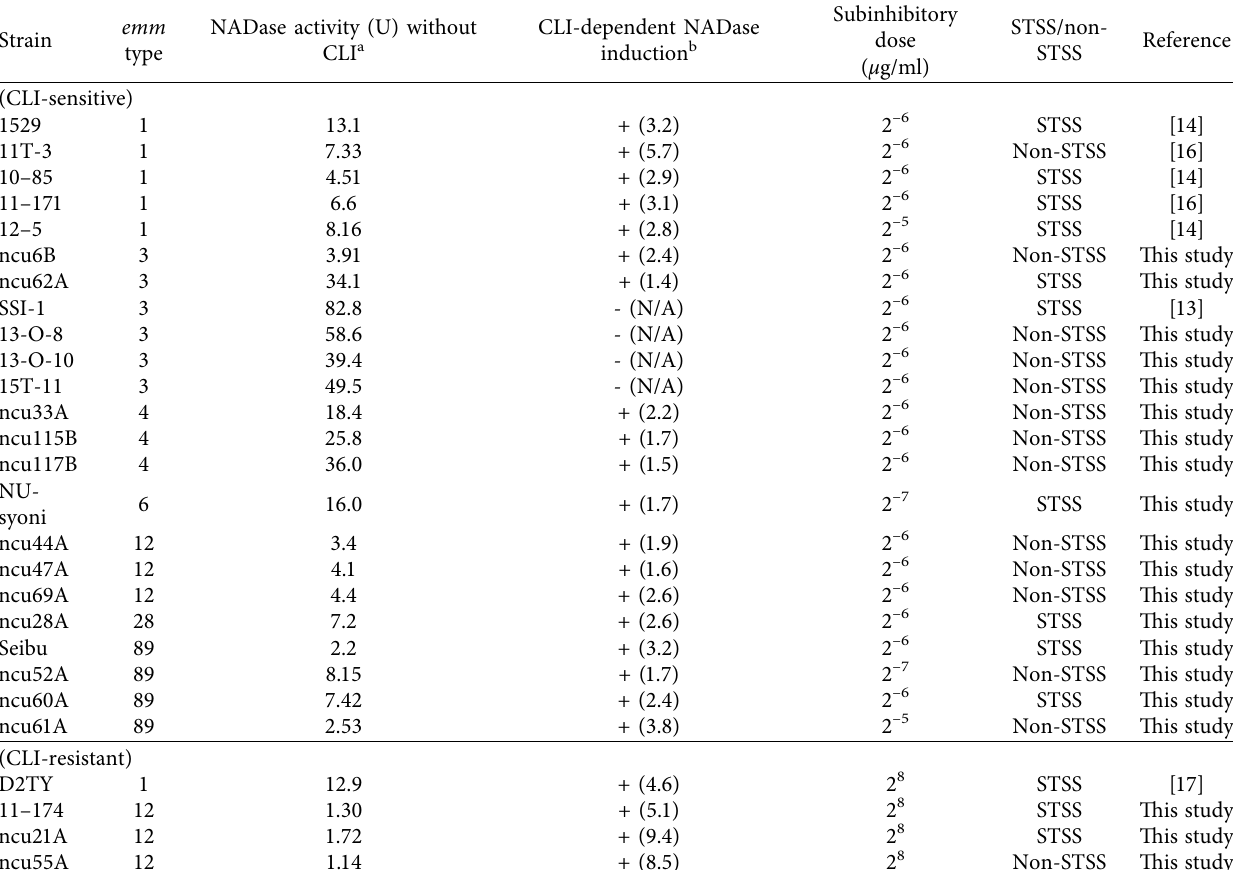
Table 1: NADase activity of culture supernatant after administration of CLI in S. pyogenes